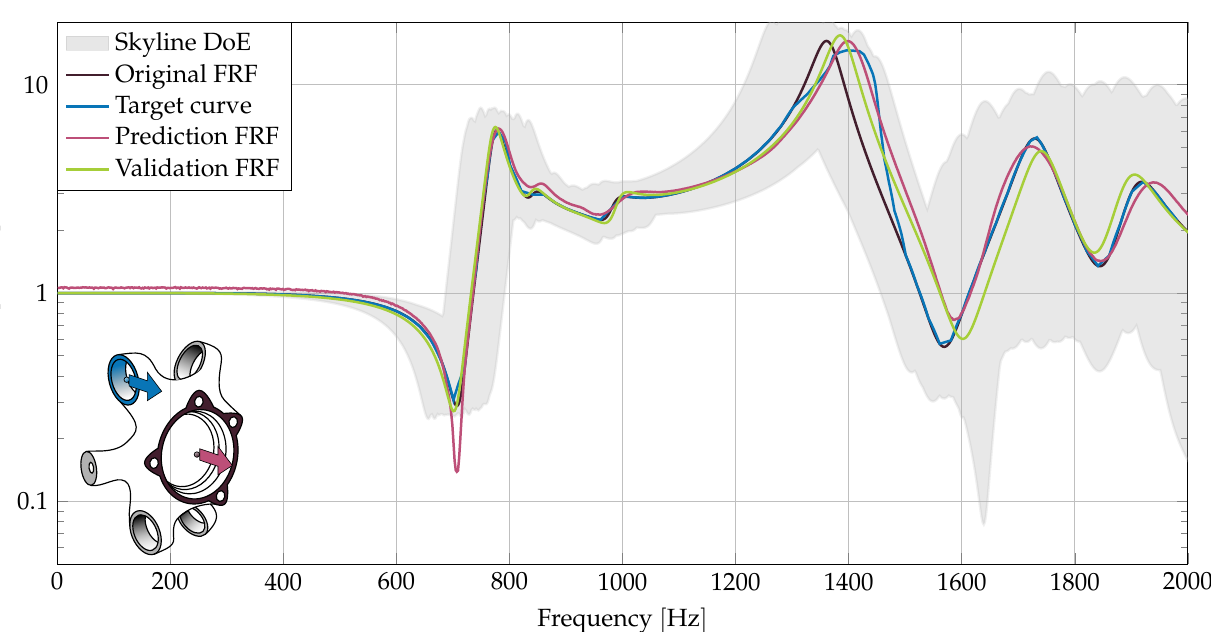
Figure 9. Optimization using a matching-curve to achieve an eigenfrequency raise and an amplitude reduction at 1350Hz.